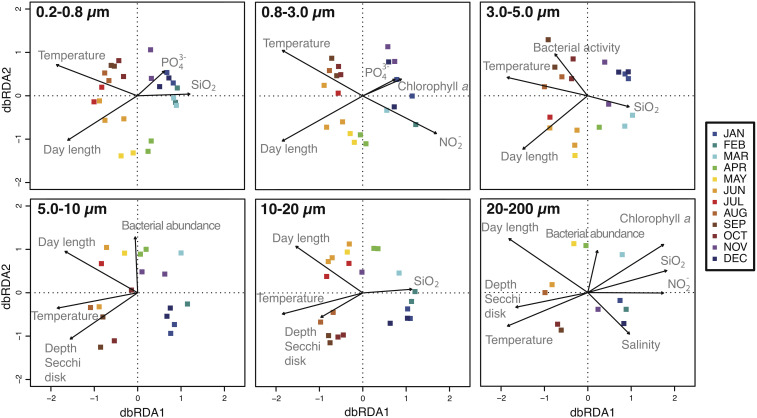
Distance-based redundancy analysis (dbRDA) representing samples over the year (square dots) and the environmental parameters that best explain the distribution of the communities (black arrows). Each panel corresponds to the different size-fractions. See section “Materials and Methods” for details.